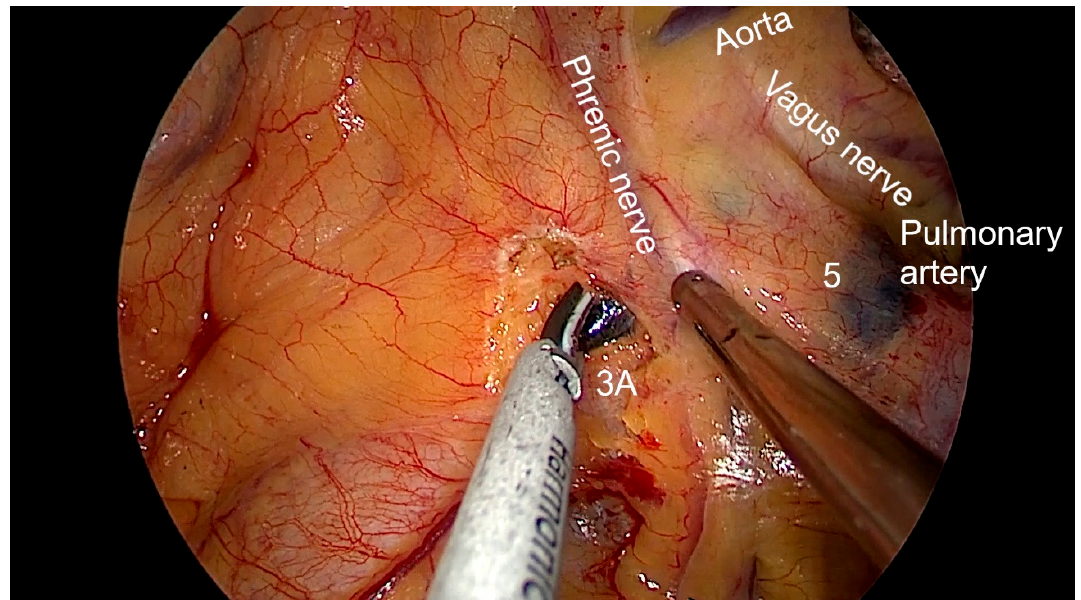
Figure 8. Anatomic landmarks during left prevascular lymph node dissection (3A).